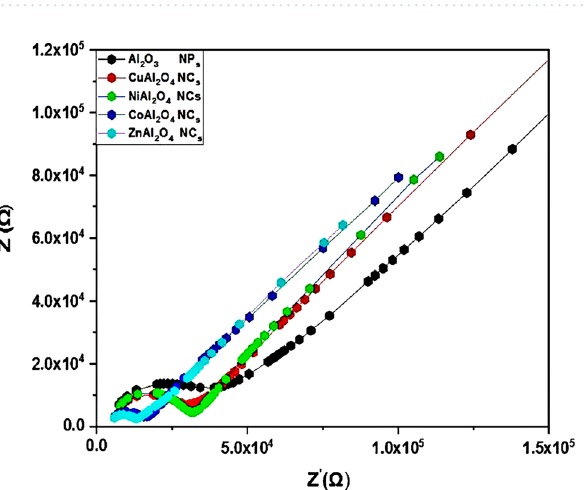
Figure 5. Absorbance spectra of ( a )-Pure MAl2O4, ( b )-ZnS/MAl2O4, ( c )-CdS/MAl2O4 and ( d )-CdS@ZnS/ MAl